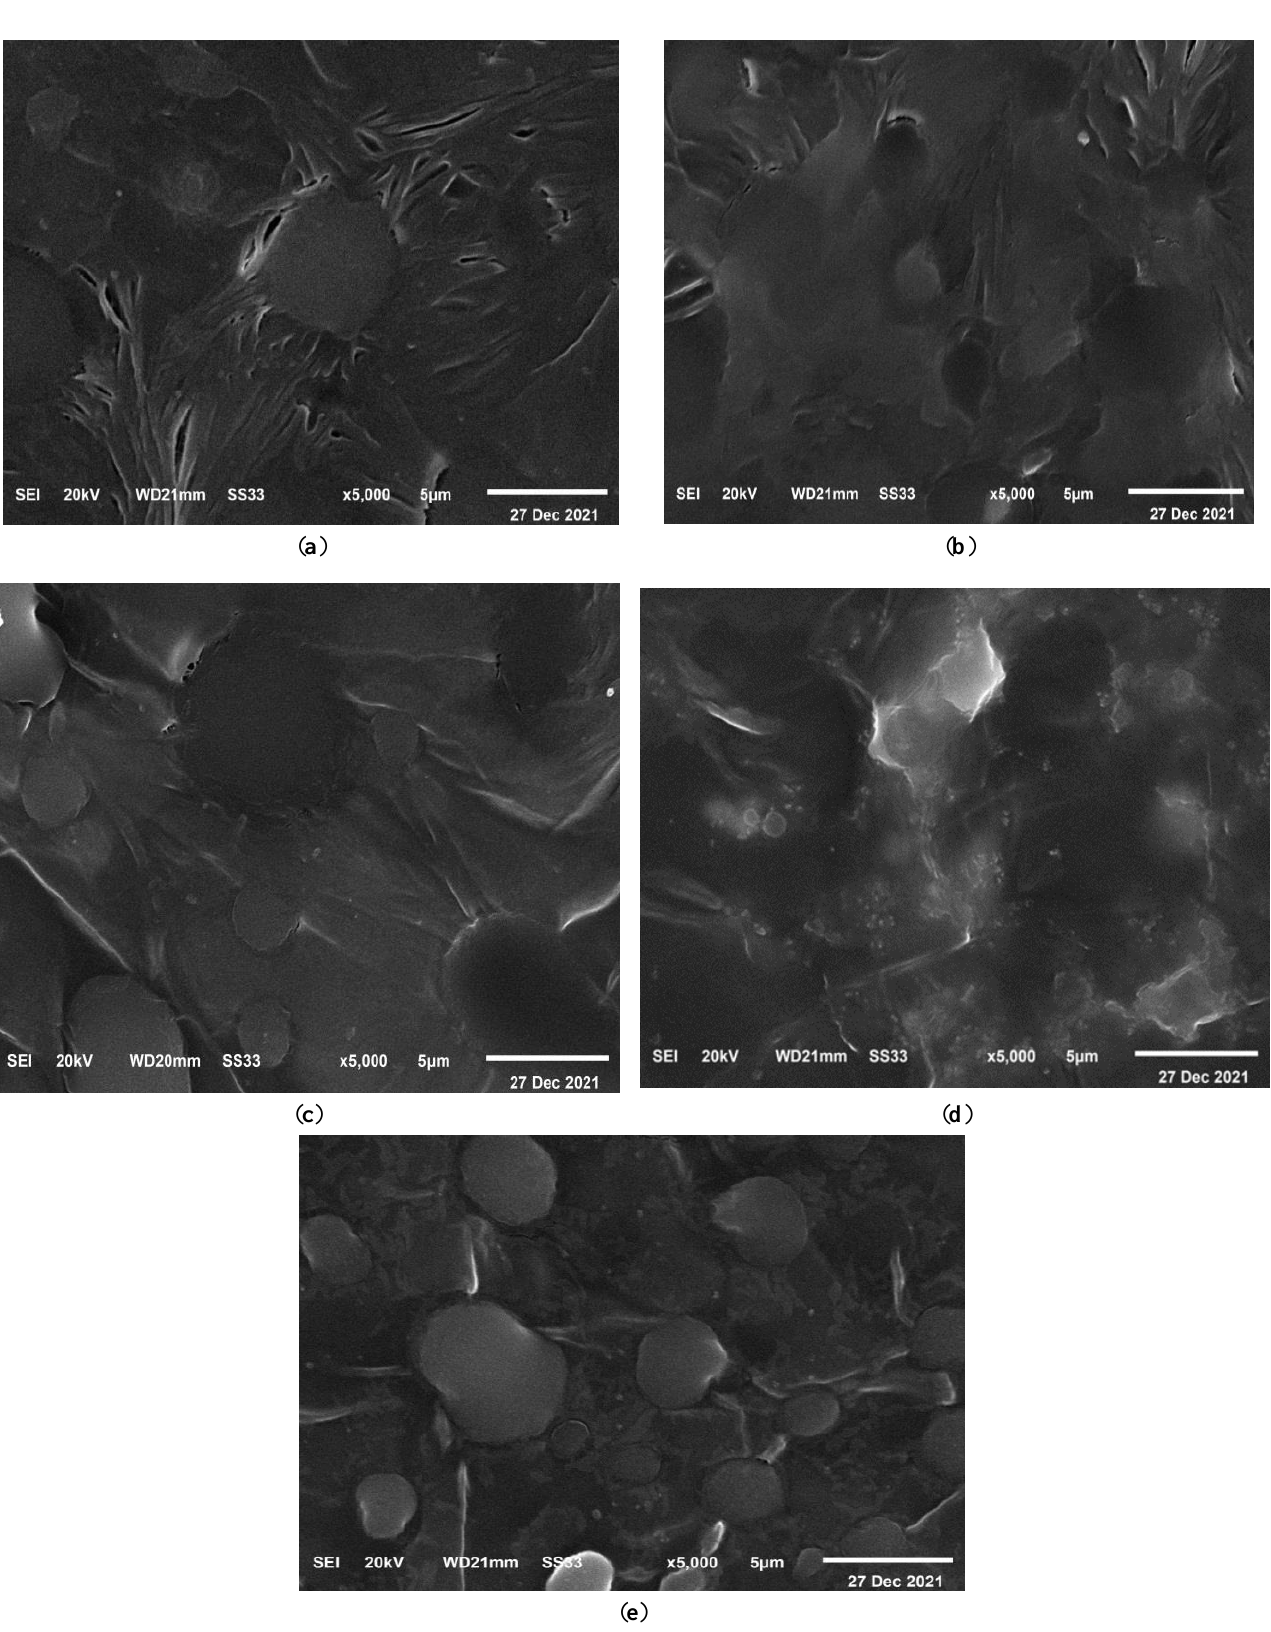
Figure 9. SEM images of ( a ) the pure PEO/CMC blend, ( b ) 0.10, ( c ) 0.20, ( d ) 0.40, and ( e ) 0.80 (wt. %) of TiO 2 NPs at mag. of 5000